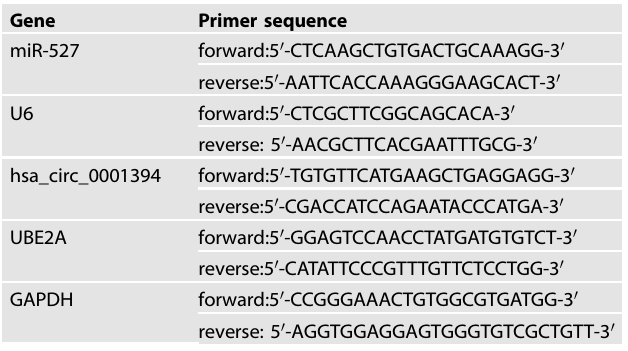
Table 1. Primers used in the present